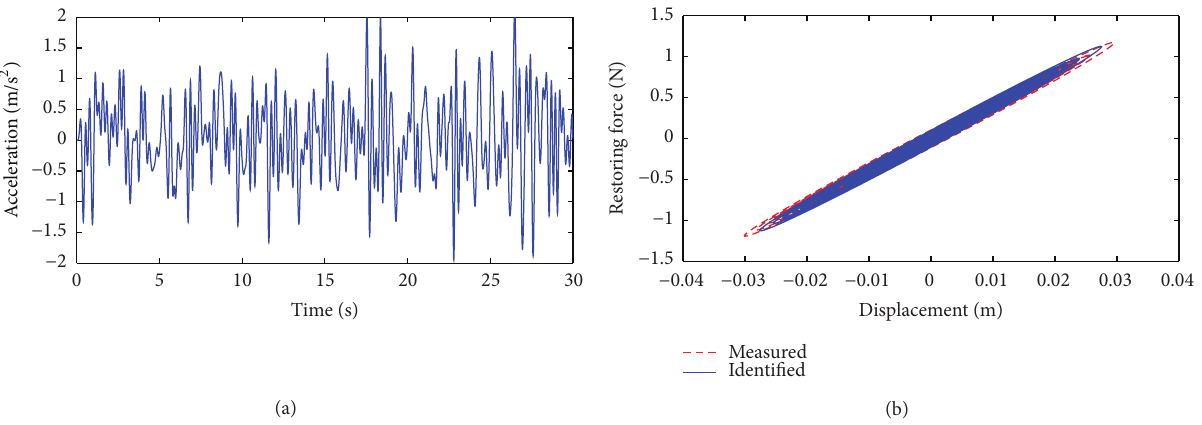
Figure 4: Test results for preexperiment: (a) white noise excitation; (b) hysteresis loops.